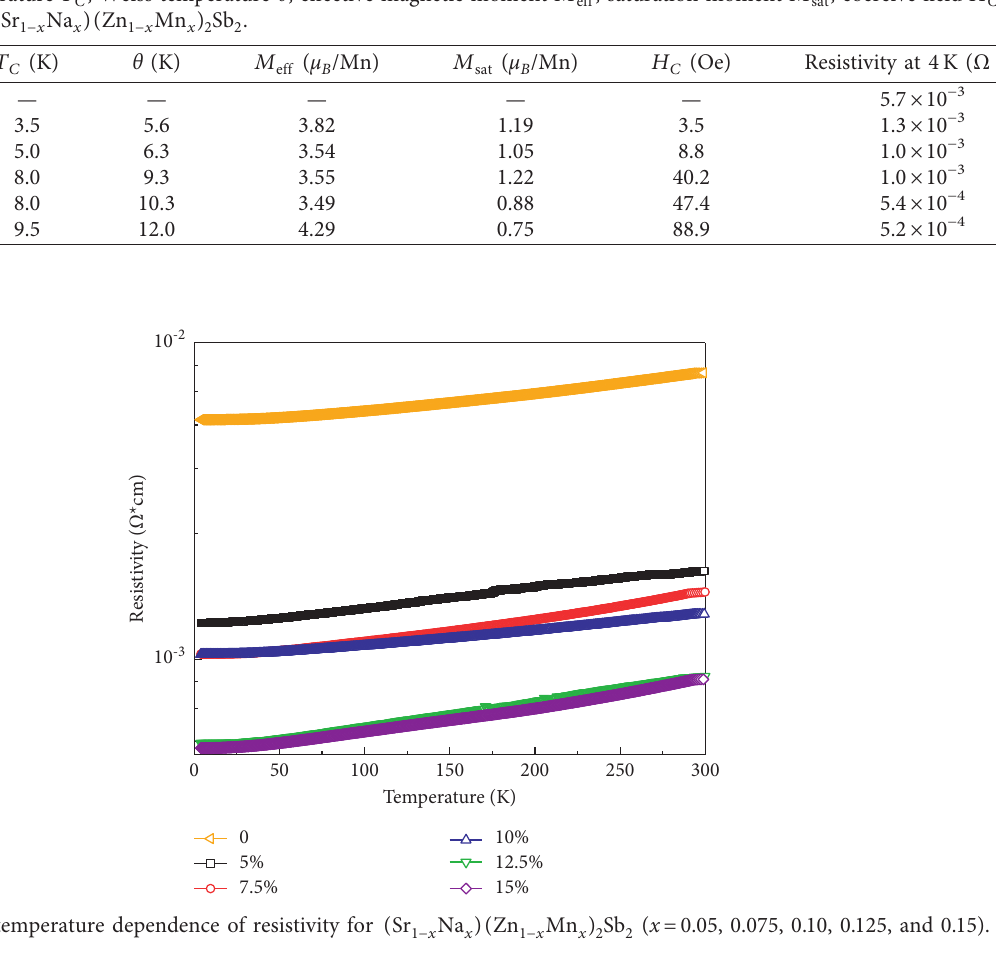
Na x )( Zn Mn x ) Sb ( x � 0.05, 0.075, 0.10, 0.125, and 1 − x 1 − x 2 2